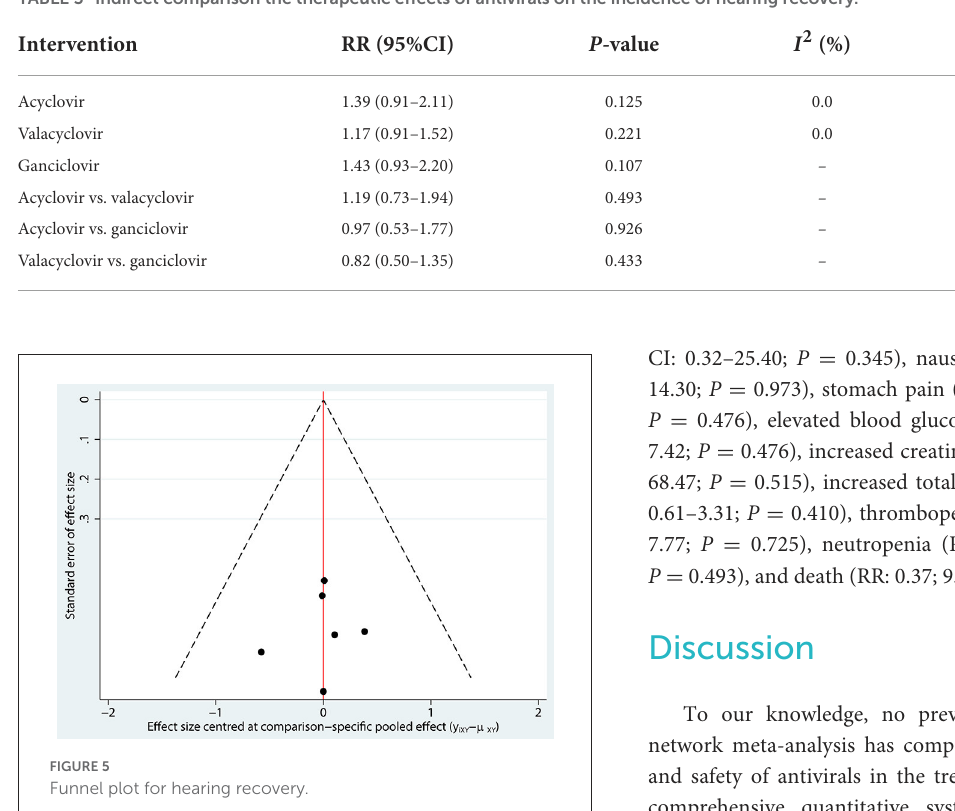
TABLE 3 Indirect comparison the therapeutic effects of antivirals on the incidence of hearing recovery.